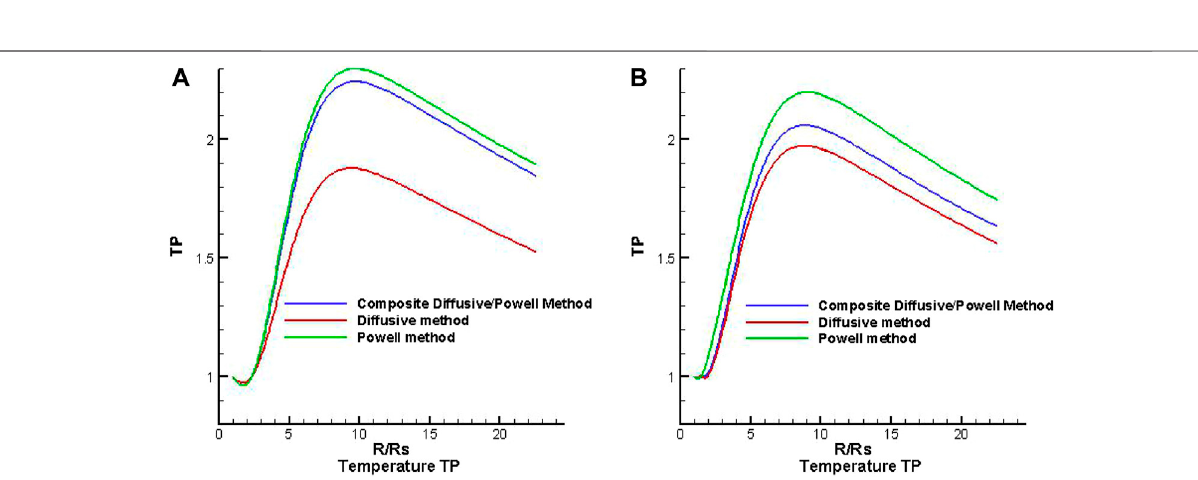
FIGURE5| Thedistributionoftemperature TP × 10 6 (K)alongheliocentricdistancewithdifferentlatitudesof θ (cid:2)− 80 ° (A) and θ (cid:2)− 10 ° (B) atthesamelongitude Φ (cid:2) 0 ° from three divergence